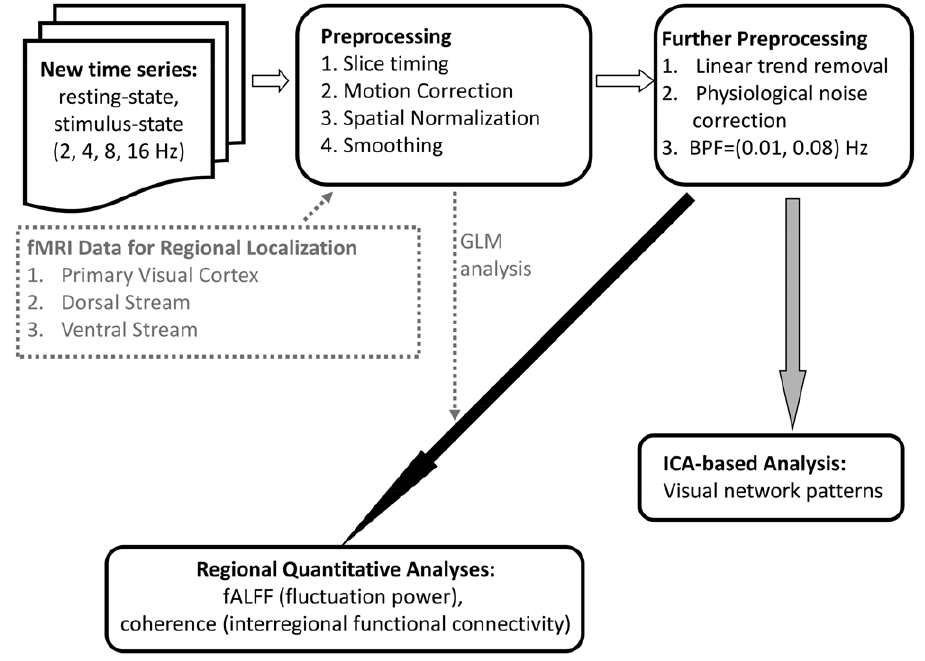
Figure 6. The flowchart of image processing in our study.